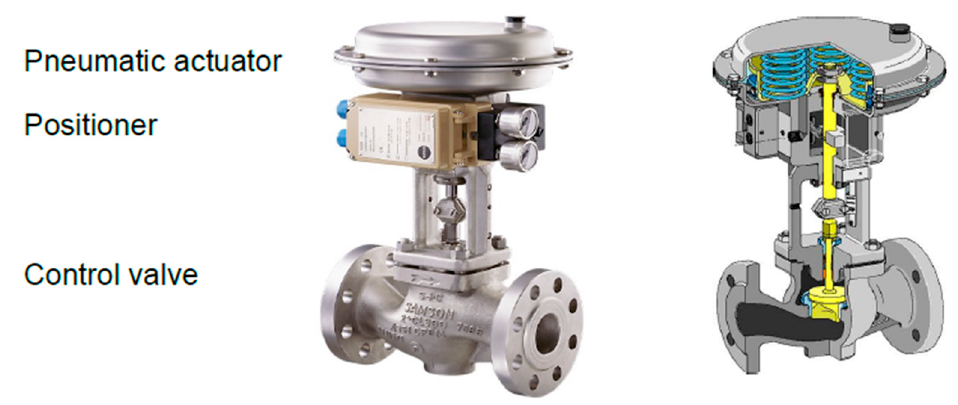
Figure 2. An example of an electro-pneumatic final control element and cross-section of its mechanical construction [4,5].